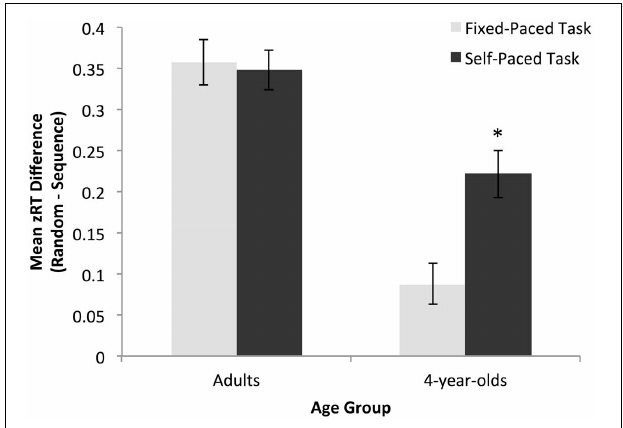
FIGURE 2 | Magnitude of the overall learning effect for adults and preschoolers in the fixed- and self-paced conditions. Adults showed equivalent learning across tasks while preschoolers had significantly greater learning scores in the self-paced condition. ∗ p < 0 .